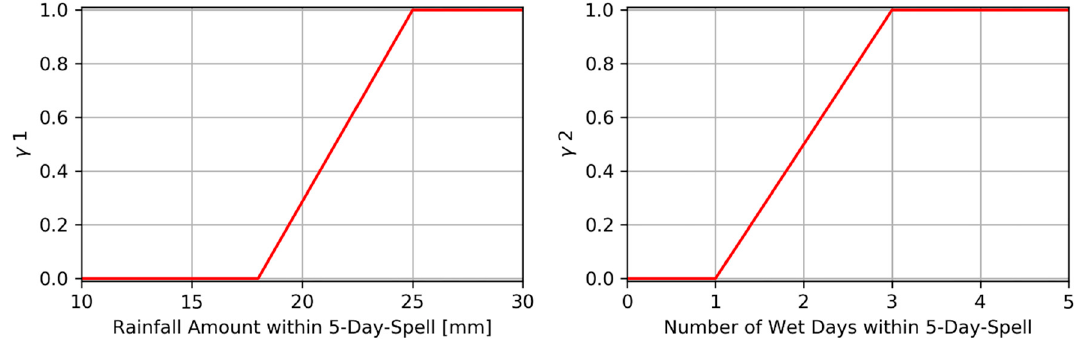
Figure 5. Membership functions of the ORS definition for γ 1 ( left ) and γ 2 ( right ), based on [17].